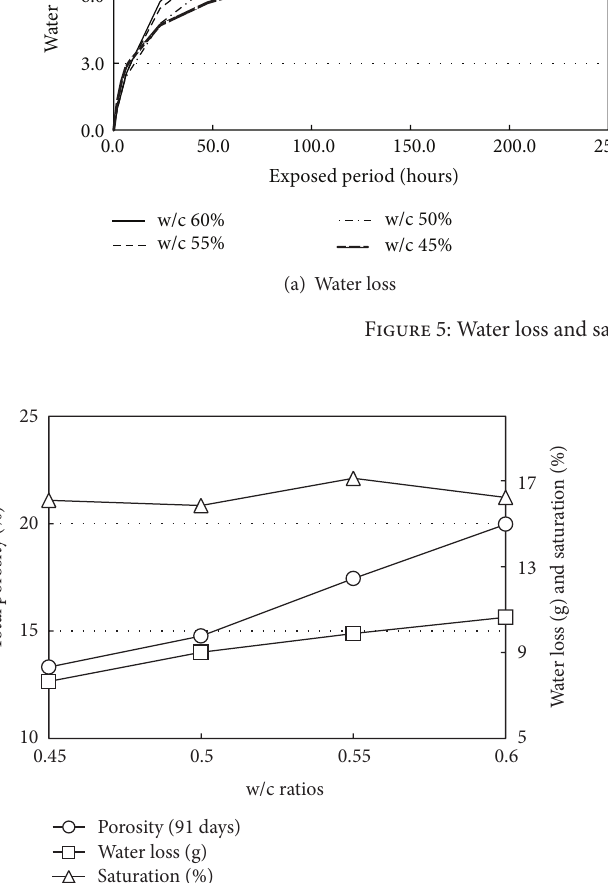
Figure 6: Water loss, saturation, and porosity with different W/C ratios.